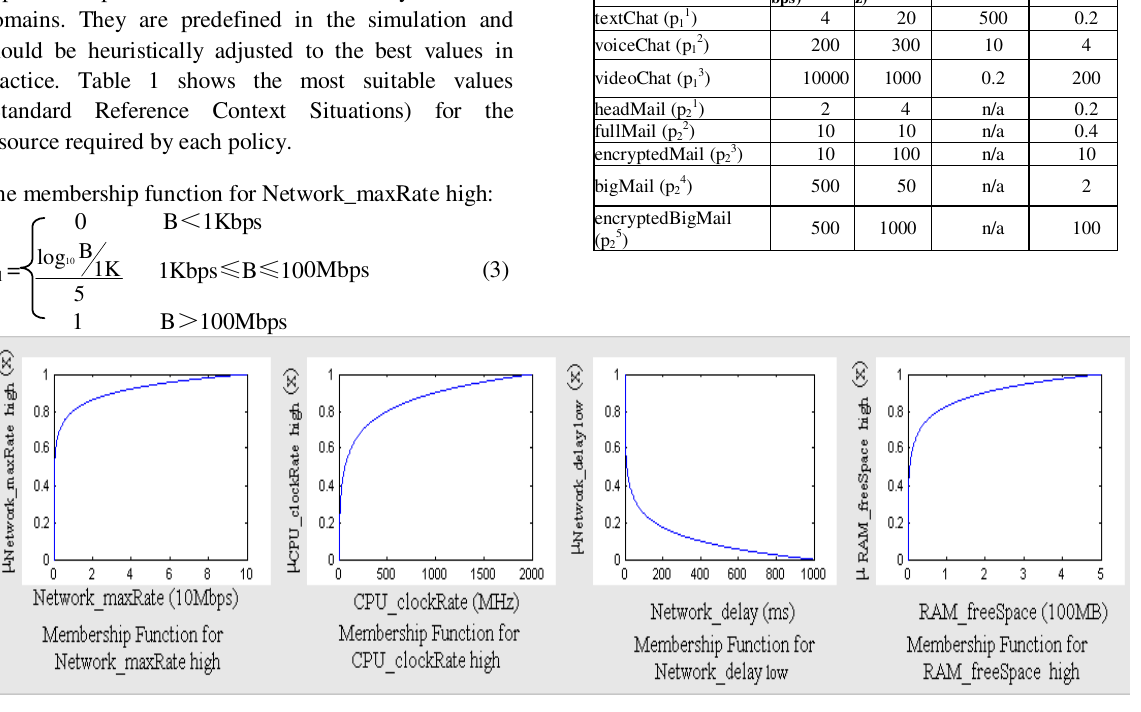
Fig. 7. The Membership